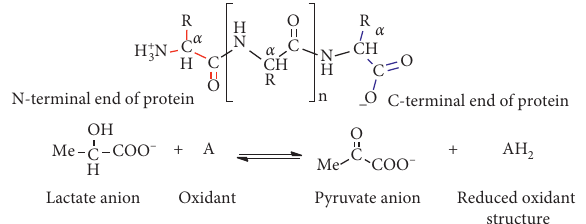
Figure 1: The interconversion of lactate and pyruvate using the enzyme lactate dehydrogenase (LDH) and amino acids sequence within one